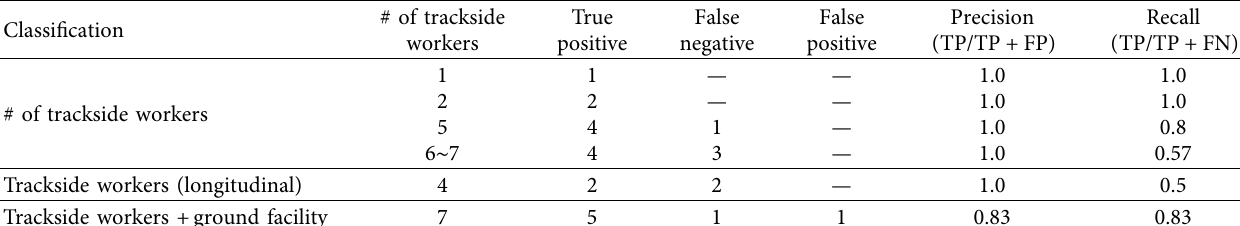
Table 3: Verification of recognizing and detecting algorithm trackside